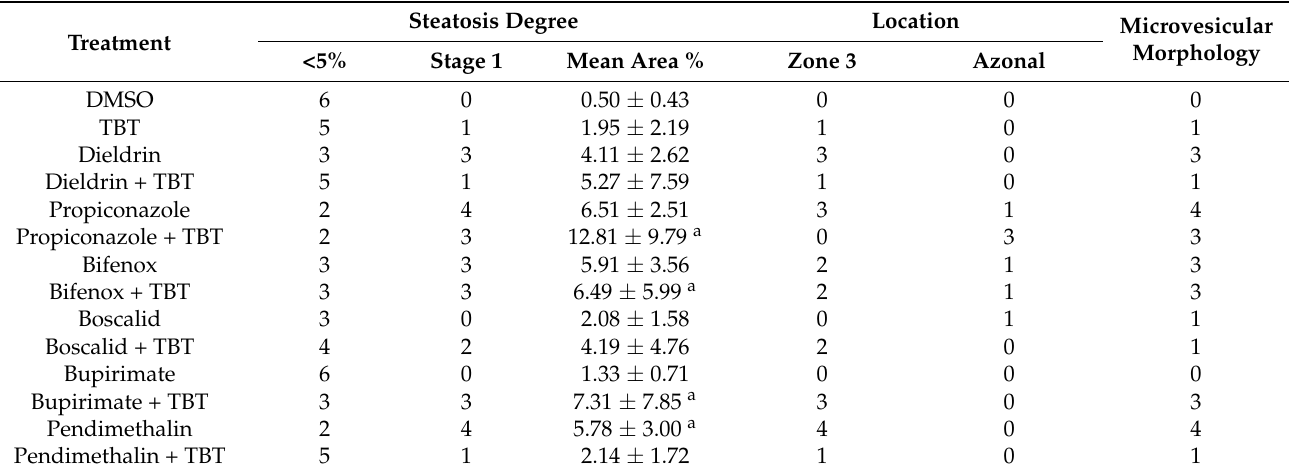
Table 3. Morphological assessment and scoring of steatoses. Data are presented as number of individ- uals per stage, per zone, per microvesicular morphology. Steatosis degrees: <5%; 5% ≤ Stage 1 < 33%. Area of lipid droplets is presented as mean ± standard error. “a” indicates significant difference with DMSO. p < 0.05 is considered significant according to one-way ANOVA test followed by Tukey’s multiple comparisons test.